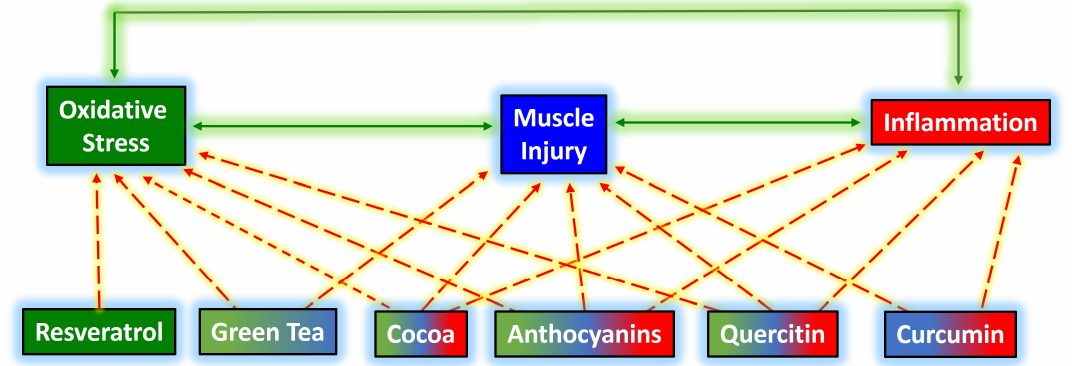
Figure 4. Flavonoid interaction with muscle injury, oxidative stress, and inflammation after exercise-induced muscle damage. Green solid lines signal communication between oxidative stress, muscle injury, and inflammation. The dotted red lines indicate the possible effects of different flavonoids.